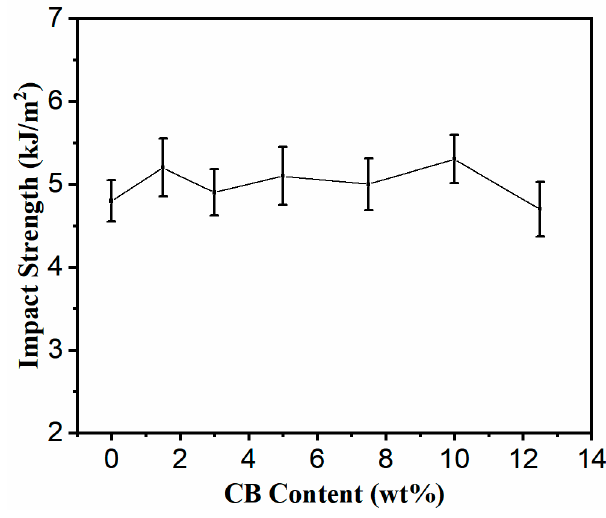
Figure 8. Impact strength of PLA70/30HDPE/CB blends with different CB loadings.